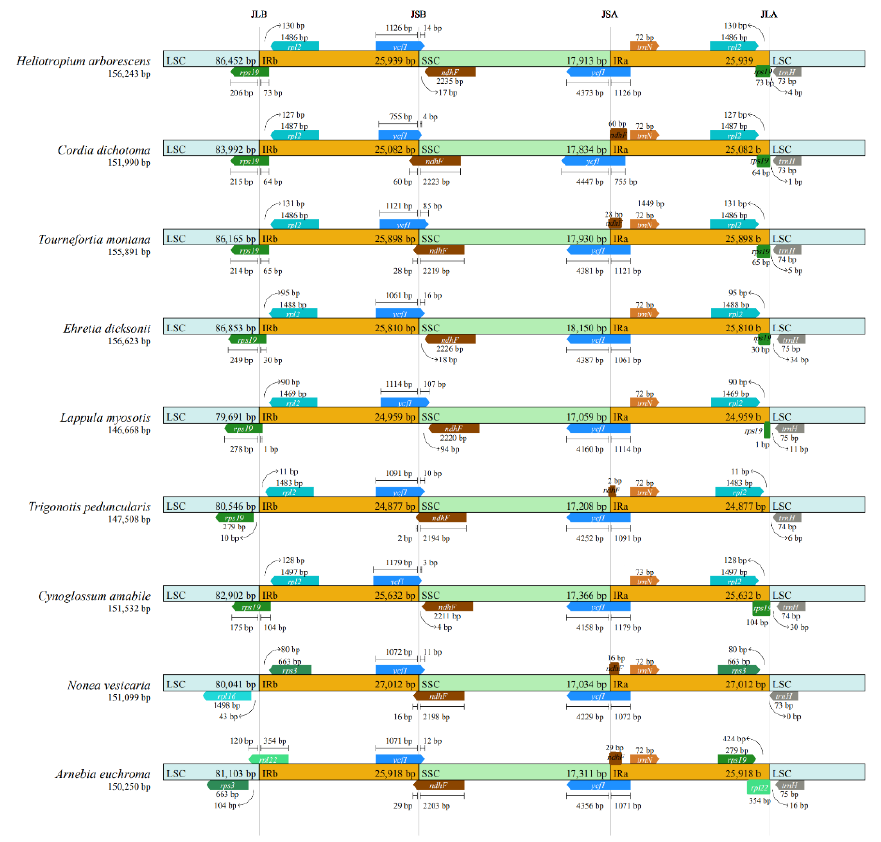
Figure 6. Comparison of the IR/LSC and IR/SSC regions of the nine species.